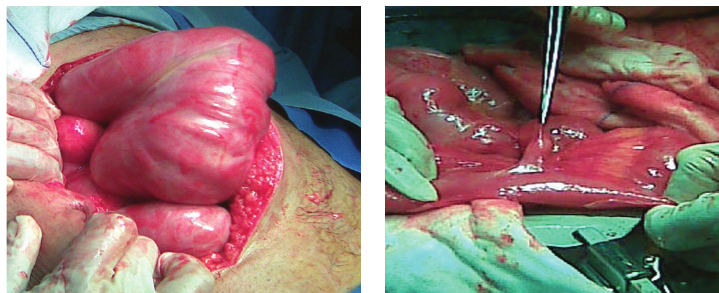
Figure 2: Intraoperative photograph shows the encapsulated small bowel with a dense fibrous